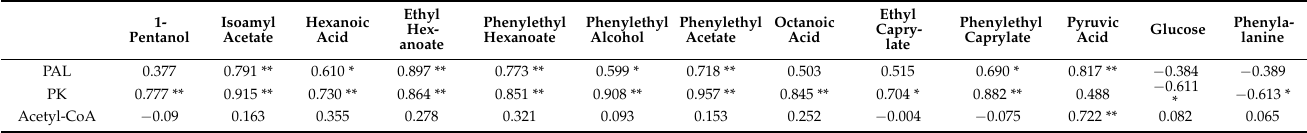
Table 2. Correlation analysis of the key enzymes and aroma components in the phenylalanine-added simulated juice